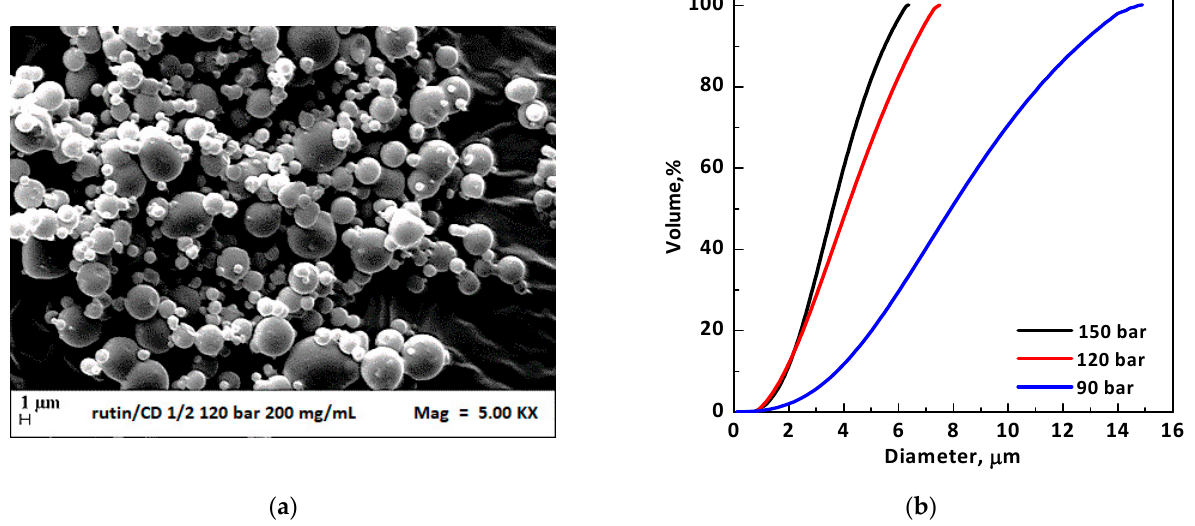
Figure 5. ( a ) FESEM image of RUT– β‐ CD 1:2 mol:mol microparticles precipitated from DMSO at 40 °C, 200 mg/mL, and 12 MPa (run #6); ( b ) volumetric PSDs of RUT– β‐ CD microparticles 1:2 mol:mol: effect of the operating pressure.